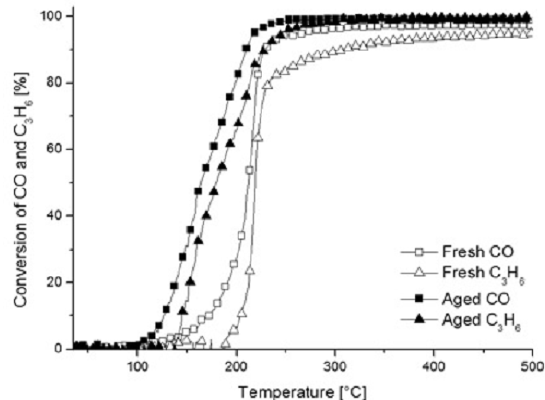
Figure 10. The conversion curves of CO and C 3 H 6 for the fresh and aged diesel oxidation catalysts. Conditions: m = 530–550 mg, 500 ppm CO, 300 ppm C 3 H 6 , and 12 vol % air, balanced with N 2 .